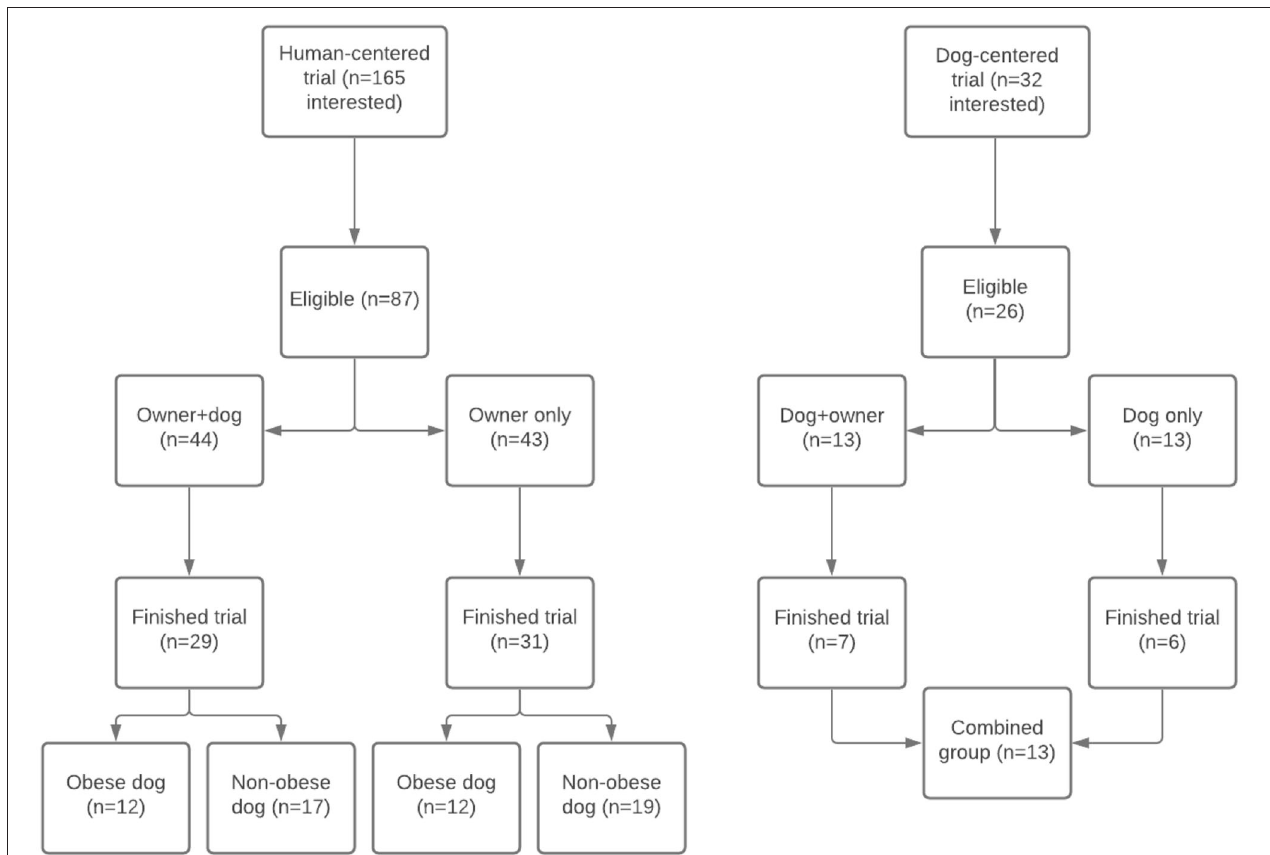
FIGURE 1 | Flow chart of participants in both